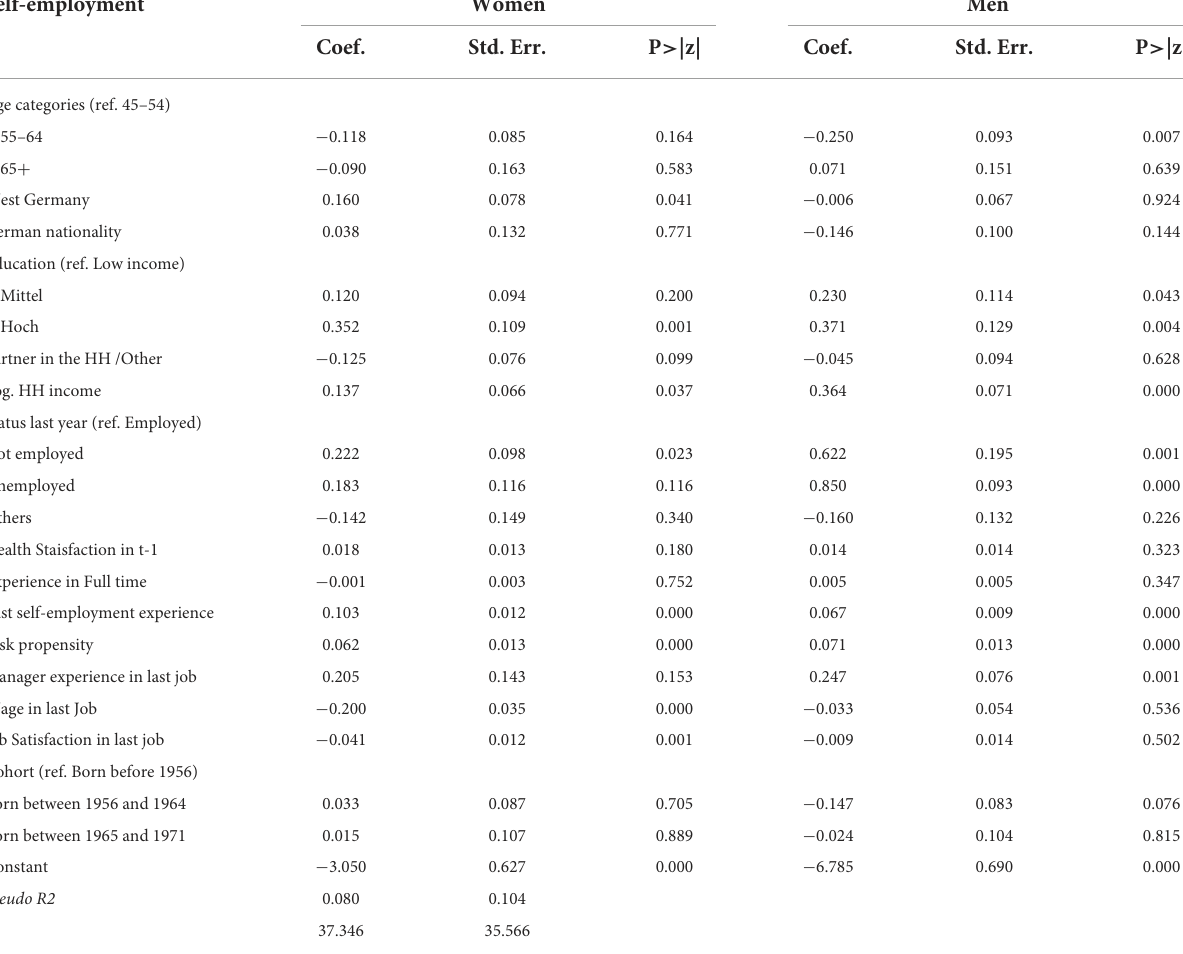
TABLE 3 Multivariate analysis of the determinant factors of late entrepreneurship. Probit. Women and men. Self-employment Women Men Coef. Std. Err. P > |z| Coef. Std.